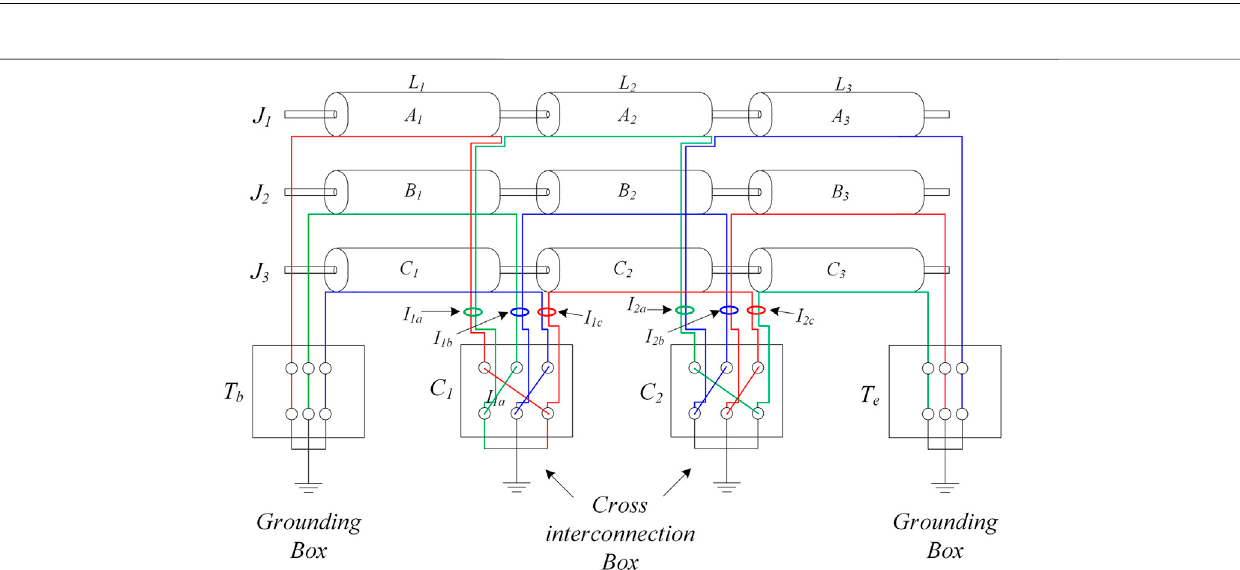
FIGURE 2 | Circuit diagram of metal sheath of high-voltage cable with cross interconnection.